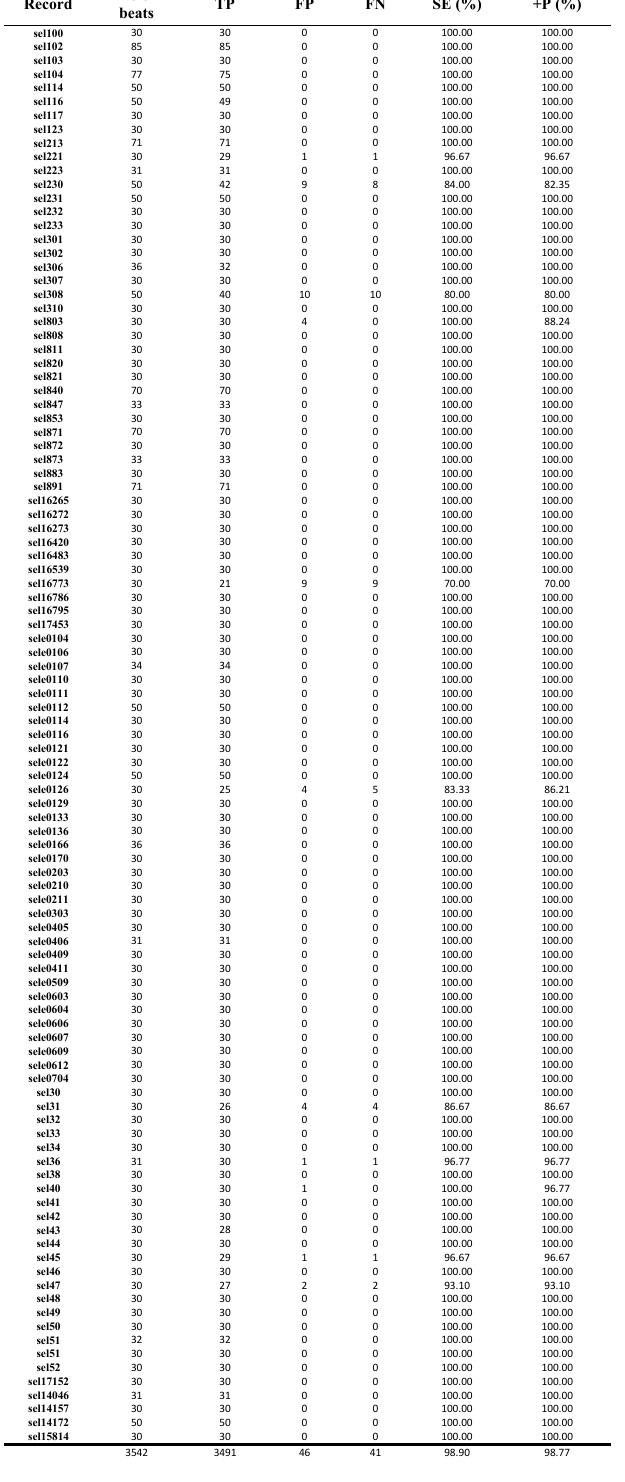
Table 2. T wave peak detection performance over the manually annotated 11 recordings of the QT database [24]. To evaluate the performance of the T wave detection algorithm, two statistical measures are used: SE = TP / (TP + FN) and +P = TP / (TP + FP) , where TP is the number of true positives (T wave peak detected within the range of 30 ms of the annotated T wave peak), FN is the number of false negatives (annotated T wave peak has not been detected), and FP is the number of false positives (T wave peak detected outside the range of 30 ms of the annotated T wave